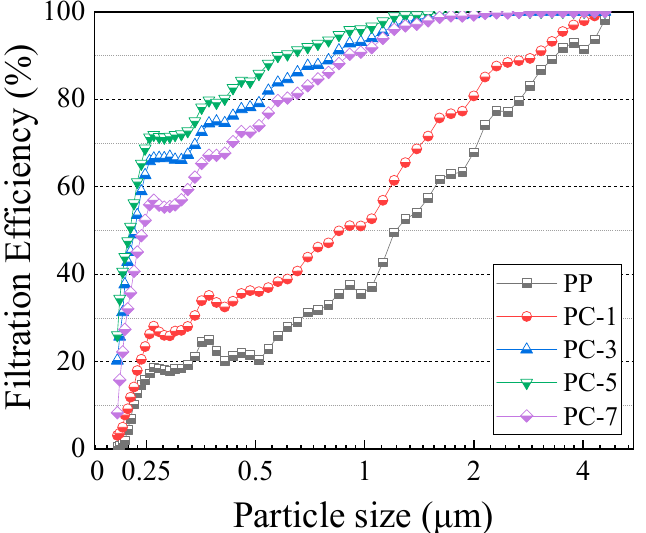
Figure 11. Filtration efficiency of DEHS (0.208–4.595 μ m) of PP meltblown membranes with different PC content at 3.4 m 3 /h flow rate. Table 5. Filtration efficiency (%) of the meltblown samples to DEHS with primary particle size of